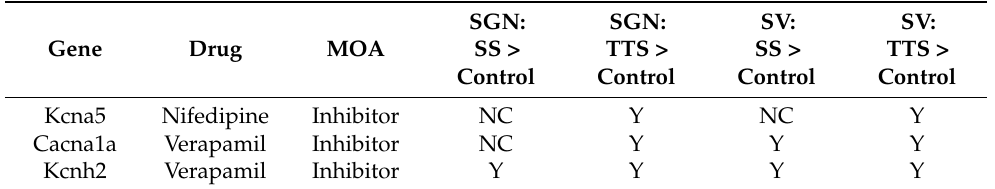
Figure 5. SIDER side effect profile on calcium channel blockers. Frequencies of the top 10 side effects shown for nifedipine and verapamil are based on the negative logarithm of their respective p values. Table 6. FDA approved, orally administered calcium channel blockers that interact with steroid- responsive genes in the cochlea localized to SGN and SV cell types.